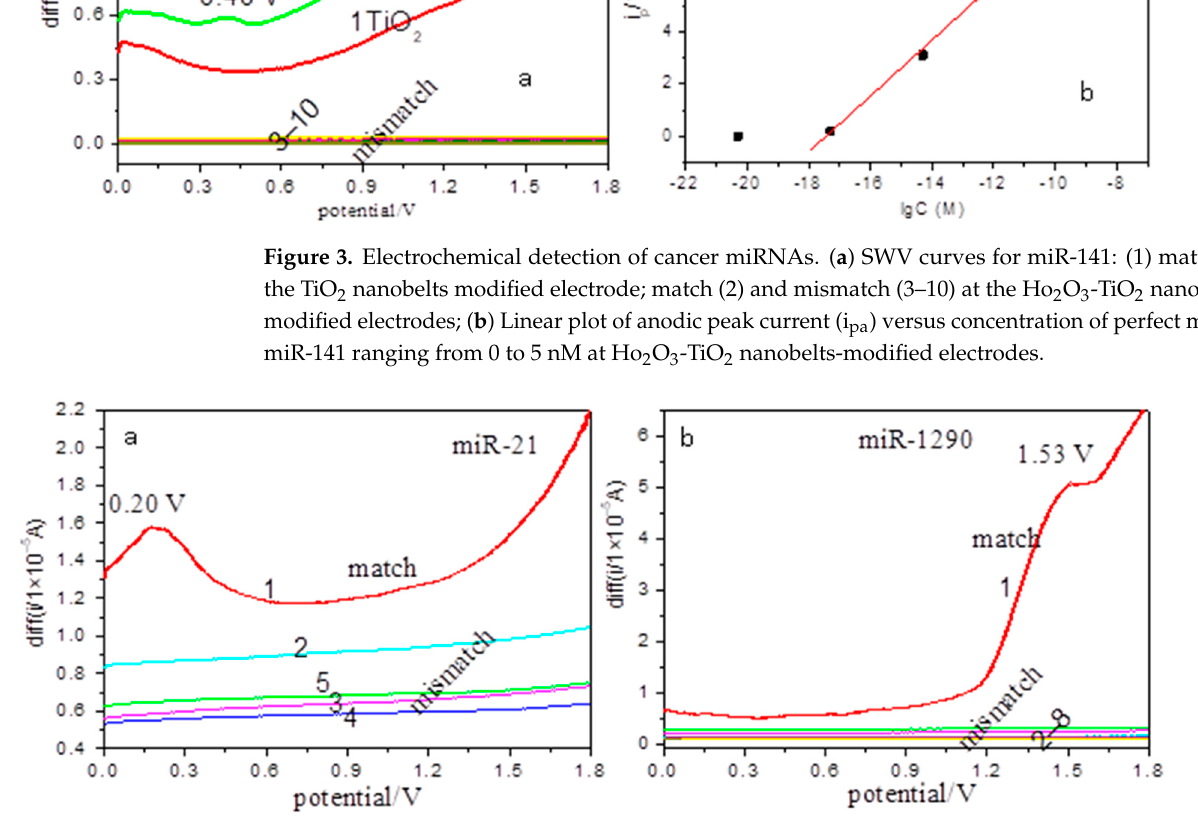
Figure 4. Electrochemical detection of cancer miRNAs at the Ho 2 O 3 -TiO 2 nanobelts-modified elec- trodes. SWV curves for ( a ) miR-21: match (1) and mismatch (2–5); ( b ) miR-1290: match (1) and mismatch (2–8).